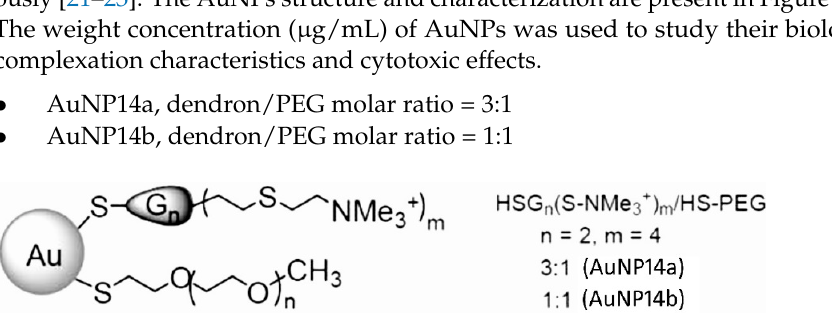
Figure 8. Structure of tested dendronized AuNPs modified with PEG. AuNPs were synthesized in water by the reaction of HAuCl 4 ·3H 2 O with a mixture of two ligands containing a thiol moiety: (1) the cationic dendrons HSG 2 (SNMe 3+ ) 4 and (2) commercial PEG ligand CH 3 O(CH 2 CH 2 O) n CH 2 CH 2 SH, HS-PEG. In addition, NaBH 4 was used as a reducing agent [21]. Table 1. Characterization of gold nanoparticles considered in this work